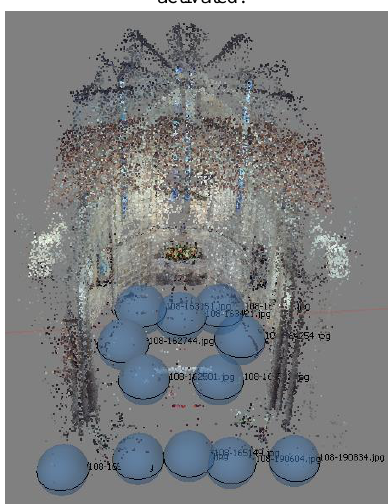
Figure 7. Santiago Ghotic apse. HDR 360º photo